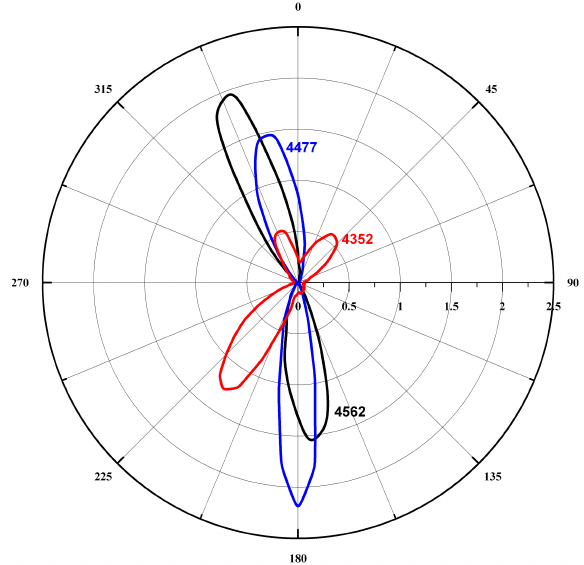
Fig. 10. Rose of the flow transports (percent per degree angle) over a period of the year based on the data of three current meters located at 4352, 4477, and